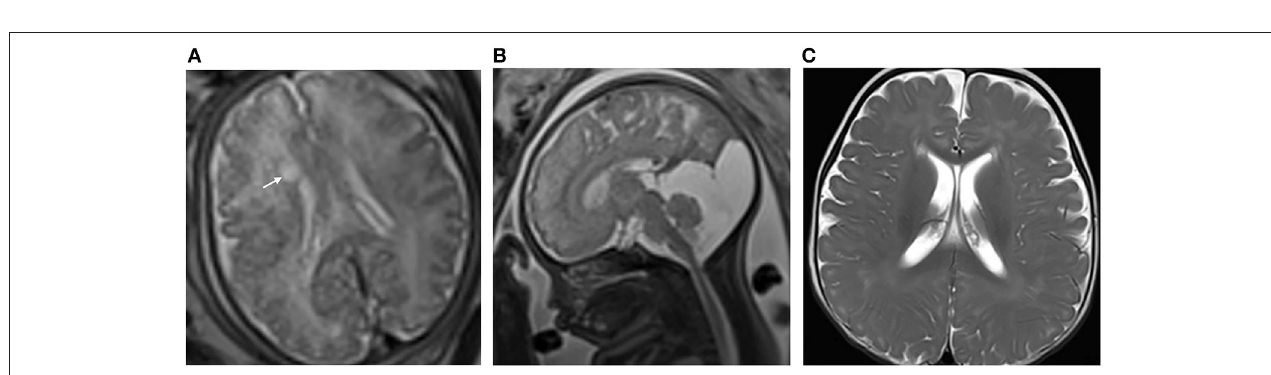
FIGURE 3 | (A) Pregnant woman, 32 years old, with a fetus of 38 weeks’ gestation. Fetal brain MRI shows a unilateral isolated periventricular pseudocyst (PVPC) located at the external angle of the lateral ventricle (white arrow); the anteroposterior diameter and height are 0.8 and 0.4cm, respectively; (B) The additional finding is the large cyst in the cisterna magna (sagittal image); and (C) Female, 9 months after birth. The PVPC disappeared, and the Gesell Developmental Scale (GDS) test and developmental quotient showed a mild neurodevelopmental disability (DQ: Adaptive: 73, Gross Motor: 58, Fine Motor: 70, Language: 69, and Personal Social: